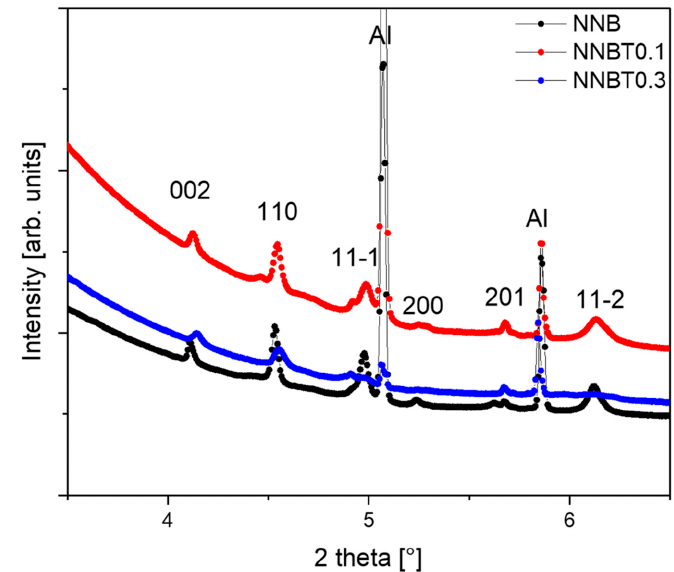
Figure 9. The reflections of O1 phase, with the space group P-31m, on the powder diffraction patterns at the high potential 3.8V. The broadening of the 11-l reflections by the appearance of stacking faults are observed in the raw of compounds: NNB, NNBT0.1 and NNBT0.3.